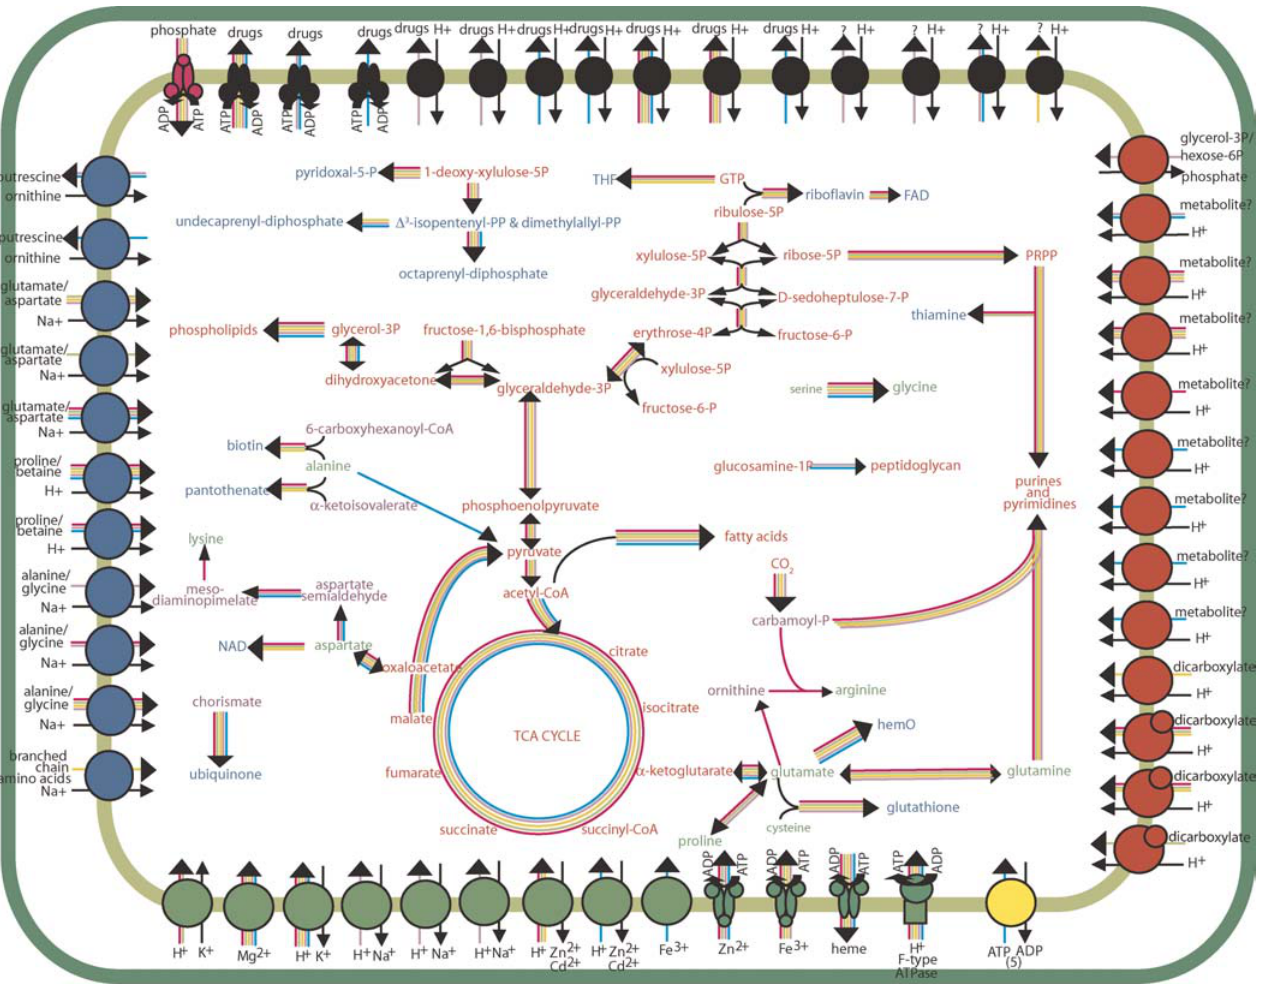
Figure 6. Comparative Metabolic Potential of Select Rickettsiales Metabolic pathways of E. chaffeensis (magenta arrows), A. phagocytophilum (green arrows), N. sennetsu (gold arrows), W. pipientis (lavender arrows), and R. prowazekii (cyan arrows) were reconstructed and compared. The networks of some of the more important pathways are shown with metabolites color coded: red and purple, central and intermediary metabolites; blue, cofactors; green, amino acids; and black, cell structures. Transporters are shown in the membrane and are grouped by predicted substrate specificity: green, inorganic cations; magenta, inorganic anions; red, carbohydrates and carboxylates; blue, amino acids/peptides/amines; yellow, nucleotides/nucleosides; and black, drug/polysaccharide efflux or unknown. DOI: 10.1371/journal.pgen.0020021.g006